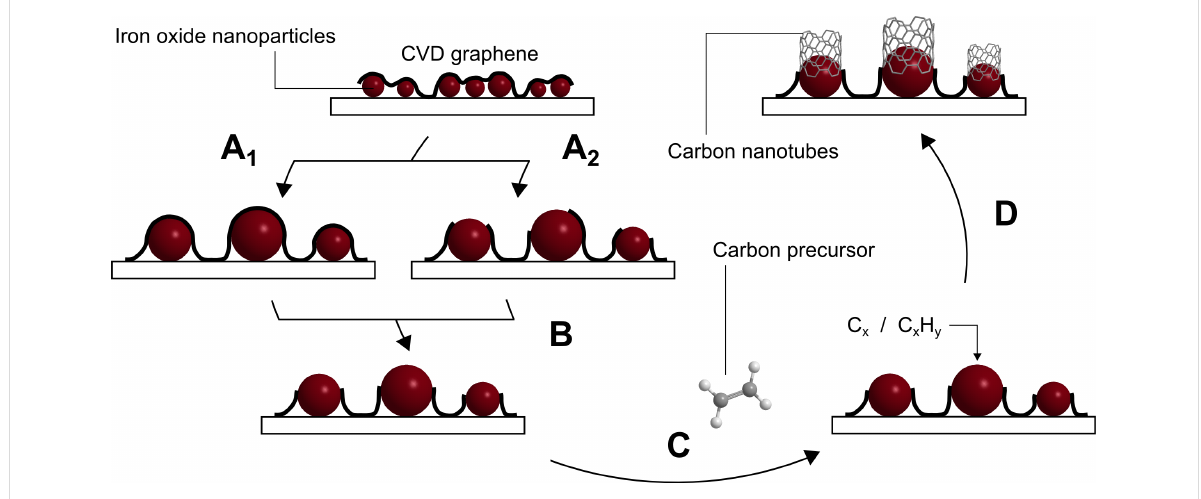
Figure 8: Proposed mechanism for the synthesis of CNTs on a metal oxide decorated graphene surface. (A) As the temperature increases during the CVD process, the iron oxide nanoparticles tend to agglomerate. The graphene can either remain intact (A 1 ) or may rupture during this process (A 2 ). (B) Graphene on the nanoparticle surface may rupture and/or decompose on the iron oxide nanoparticle surface at higher temperatures. (C) Synthe- sis of CNTs is initiated by exposure of the iron oxide nanoparticle surface to the carbon precursor. (D) Growth of CNTs on top of the graphene. Note that the metal oxide particles are found underneath the graphene layer as the etchant solution agitates from